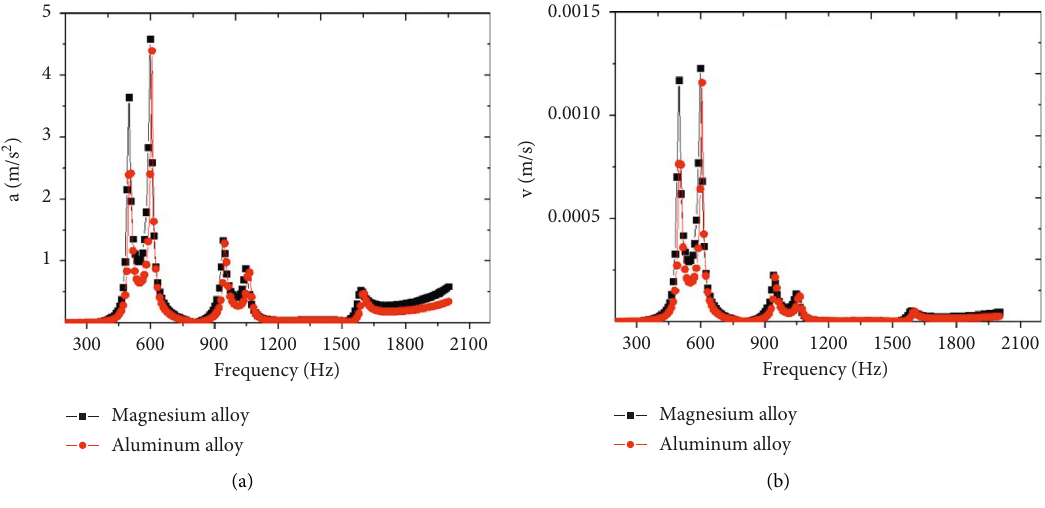
Figure 10: Comparison of wheel response